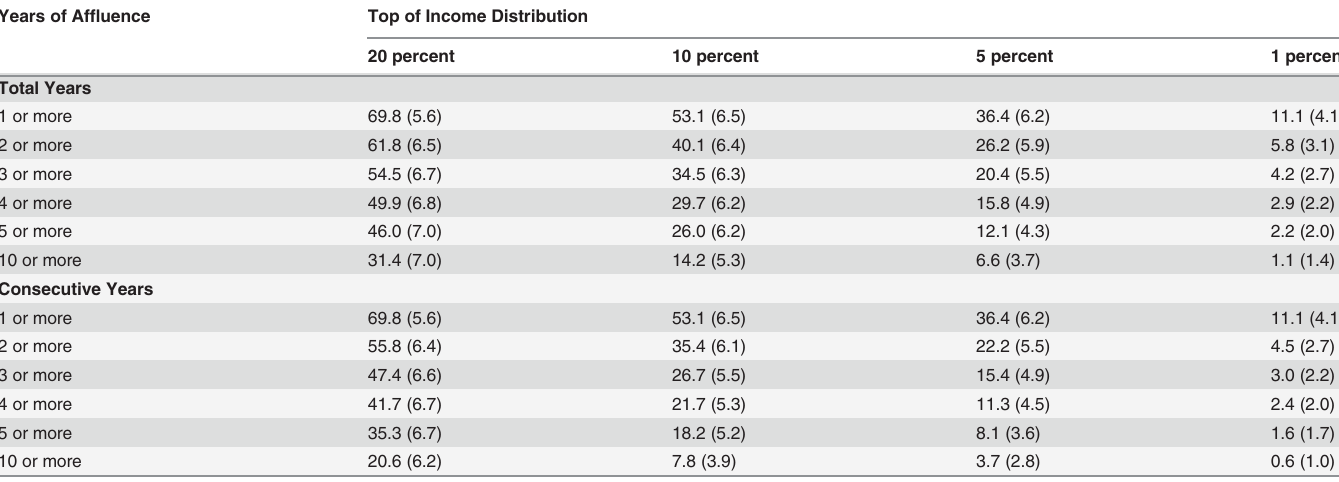
Table 2. Cumulative Percentage of American Adults Experiencing Various Years of Household Af fl uence (Standard Errors in Parentheses).